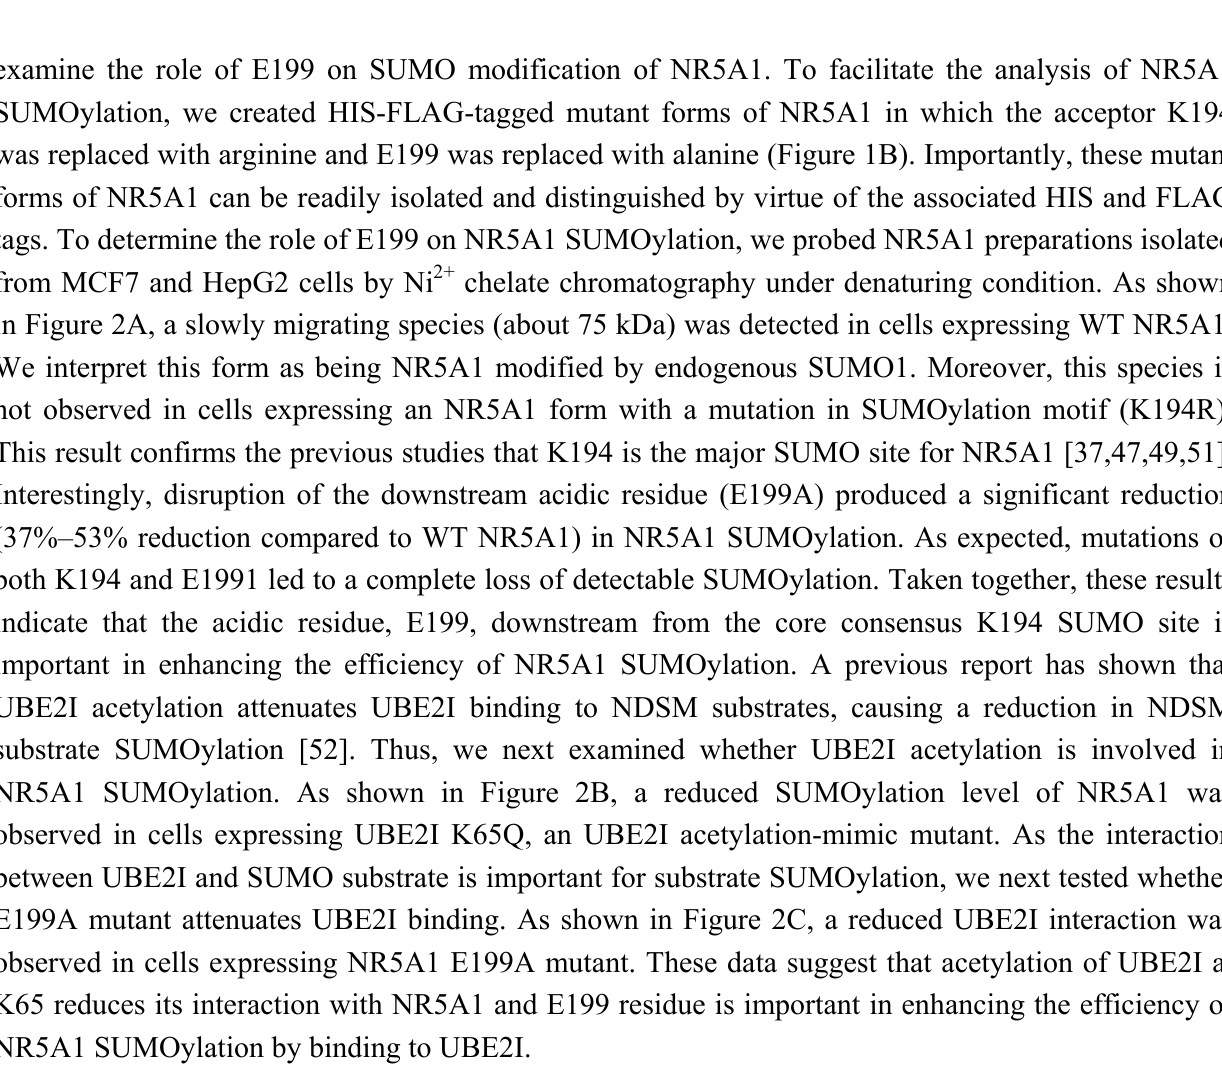
Figure 1. Protein sequence alignment of NR5A1 and experimental strategy. ( A ) Sequence alignment of the human, monkey, cow, mouse, and rat NR5A1 proteins showing the regions that contain the potential SUMO site (S) followed by 12–13 downstream amino acids including phosphorylation site (P); ( B ) Schematic representation of the mouse NR5A1 protein with the lysine-to-arginine and/or glutamic acid-to-alanine NR5A1 mutants generated in this study to determine potential SUMOylation sites and activities on